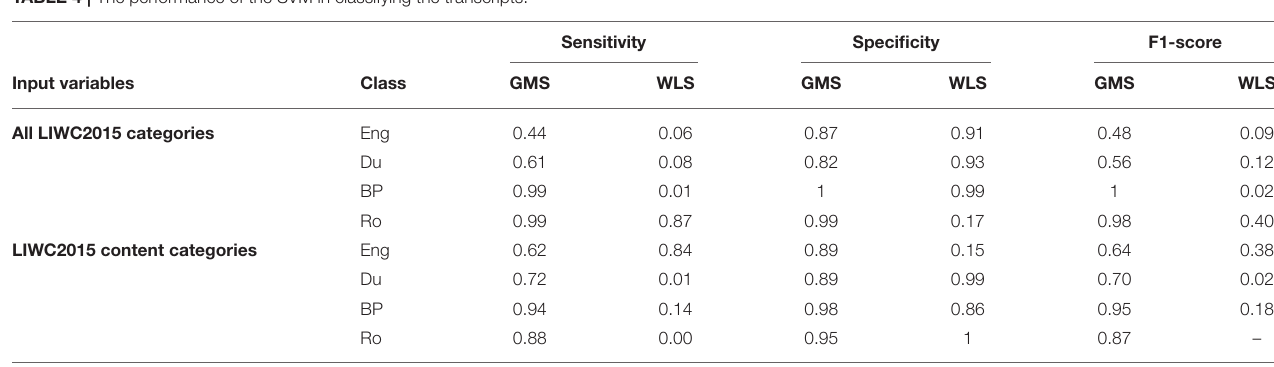
TABLE 4 | The performance of the SVM in classifying the transcripts.